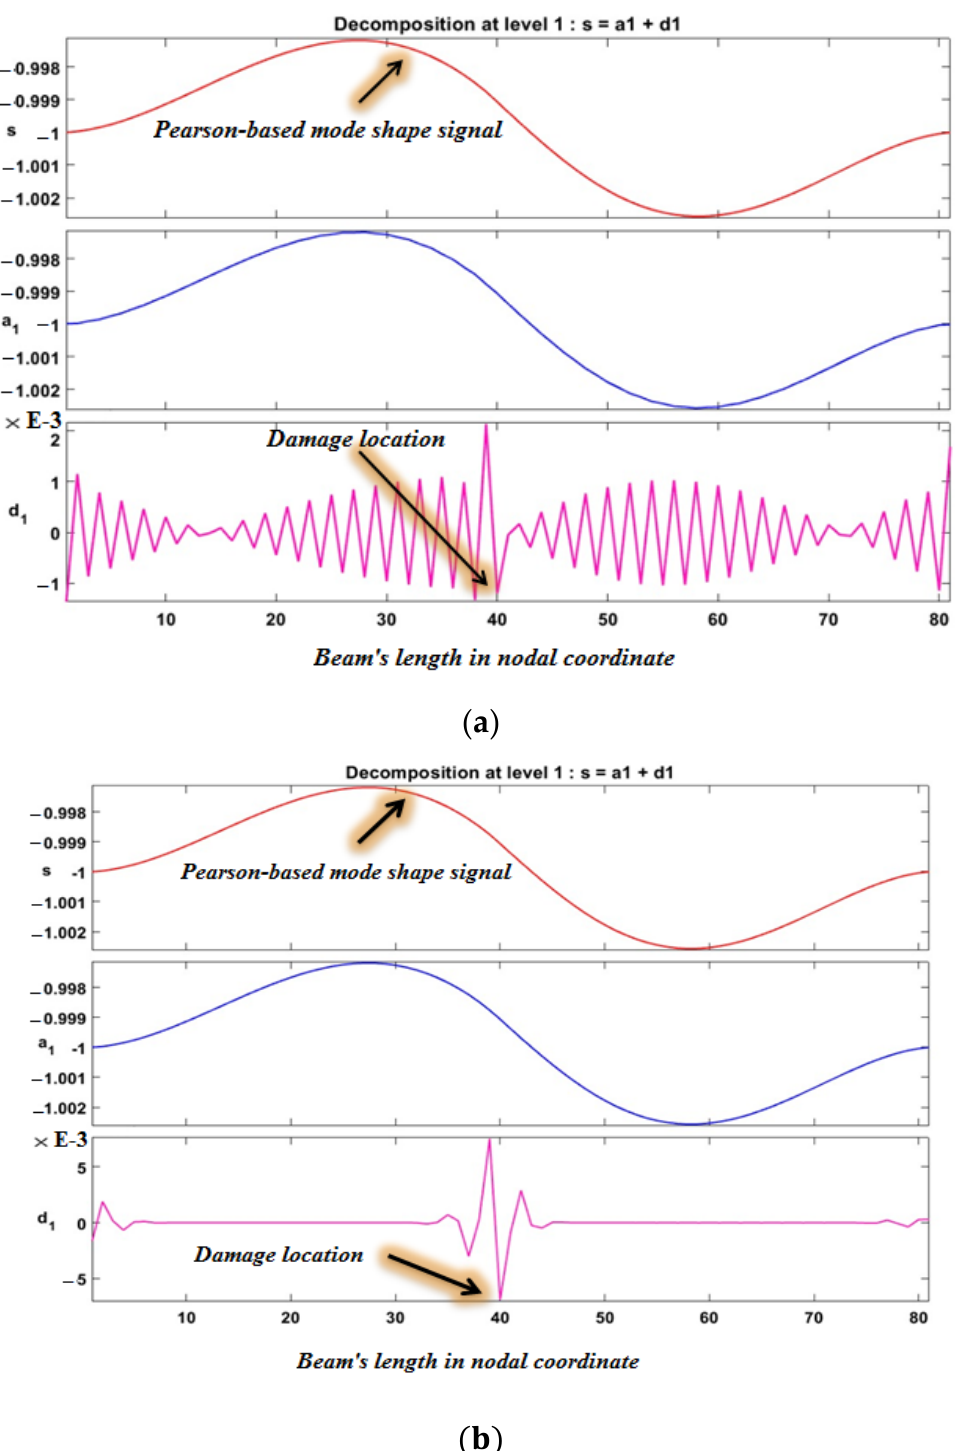
Figure 8. The effect of increasing the vanishing moments on the accuracy of damage detection by 1D-DWT from the quasi-Pearson-based mode shape signal by 90% damage: ( a ) vanishing moments = 2, ( b ) vanishing moments = 5.